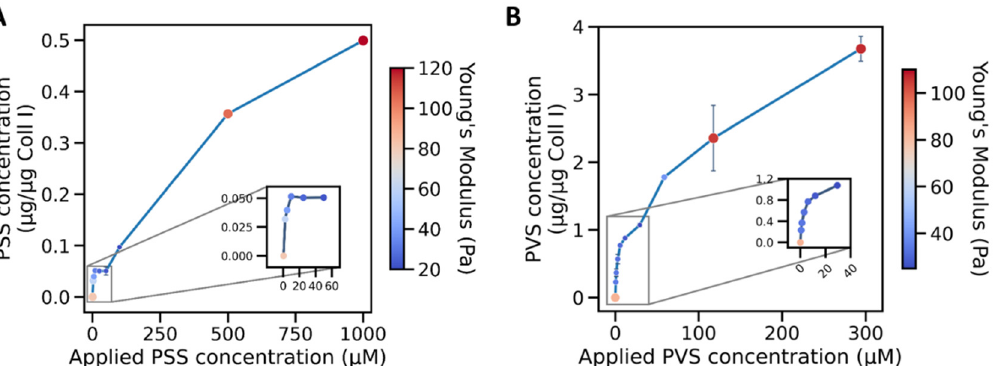
Figure 5. Kinetics of the adsorption of PSS and PVS on 3D Coll I matrices overlaid with respective Young’s moduli. Amount of adsorbed poly(styrene sulfonate) (PSS) ( A ) and poly(vinyl sulfonate) (PVS) ( B ) on fibrillar Coll I networks (normalized to the amount of Coll I in the network, approximately 100 µ g) in dependence on the functionalization concentration. The stiffness of the corresponding matrices is shown as a color-coded overlay. Single Young’s moduli for mono- & multilayer states are compared with unfunctionalized Coll I networks in Figure